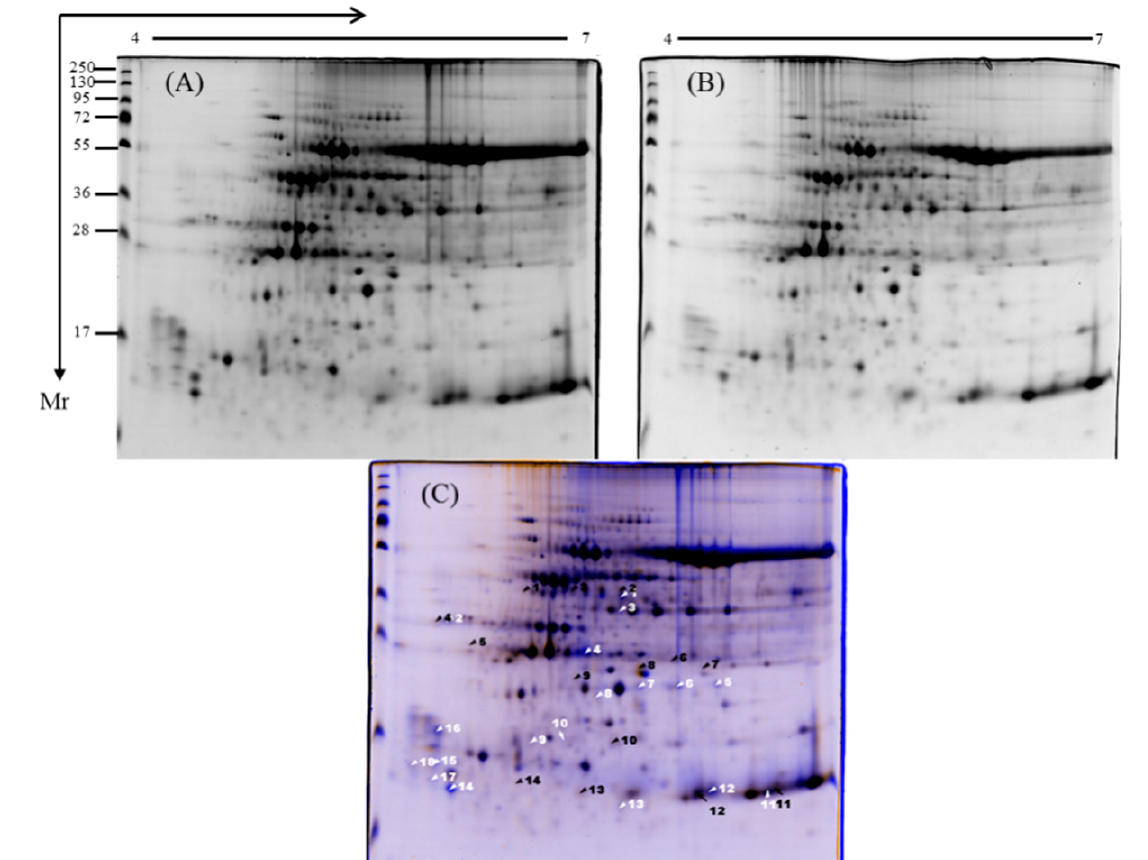
Figure 4. Two-dimensional electrophoresis map of diploid and tetraploid watermelon and screening of differential proteins. Proteome patterns of leaves in ( A ) diploid watermelon and ( B ) tetraploid watermelon; ( C ) 2-DE map showing differential proteins from two polyploid watermelons. White and black arrows indicate differentially expressed proteins of tetraploid compared with diploid watermelon (fold change >2, p -values < 0.05); white arrows indicate upregulated protein spots and black arrows indicate downregulated protein spots.